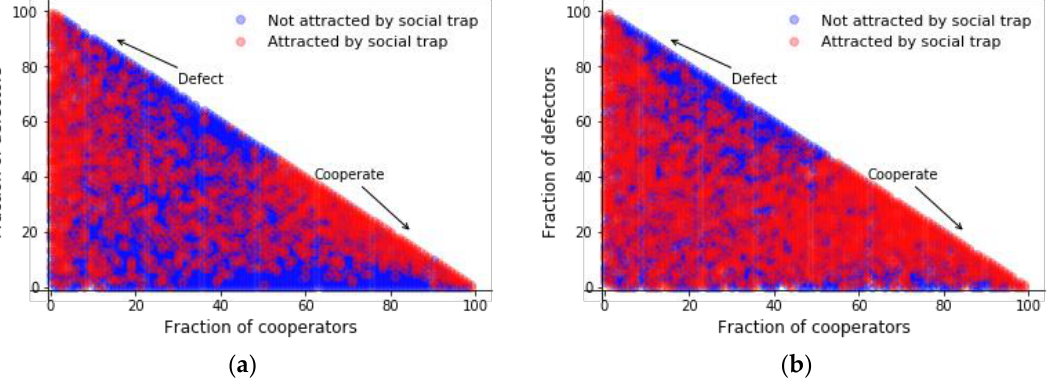
Figure 4. Cultural evolutionary dynamics with incentive. The parameters are N = 5, c = 1, g = 0.5, r = 3 (plot on the left = a), and r = 1.8. (plot on the right = b), with individuals attracted by the social trap. Both plots (a, b) show the categorized strategies (cooperators = blue, defectors = red).